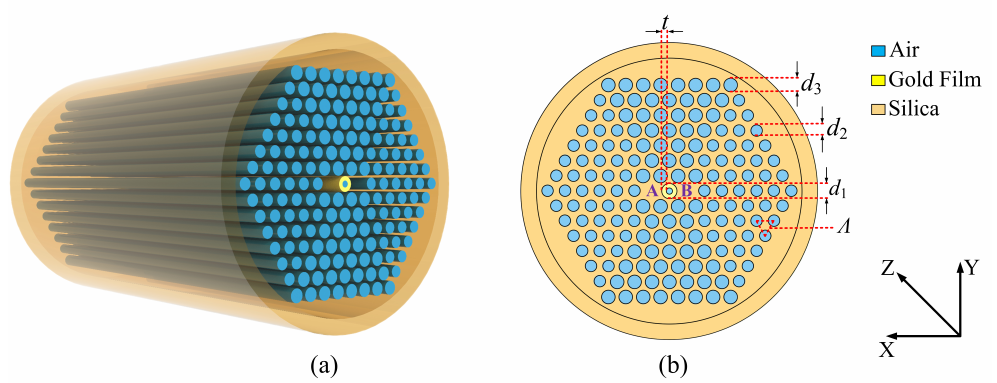
Figure 1. The three-dimensional ( a ) and cross-sectional ( b ) structures of the proposed V-shape dual-core photonic crystal fiber (V-DC-PCF) polarization beam splitter (PBS).